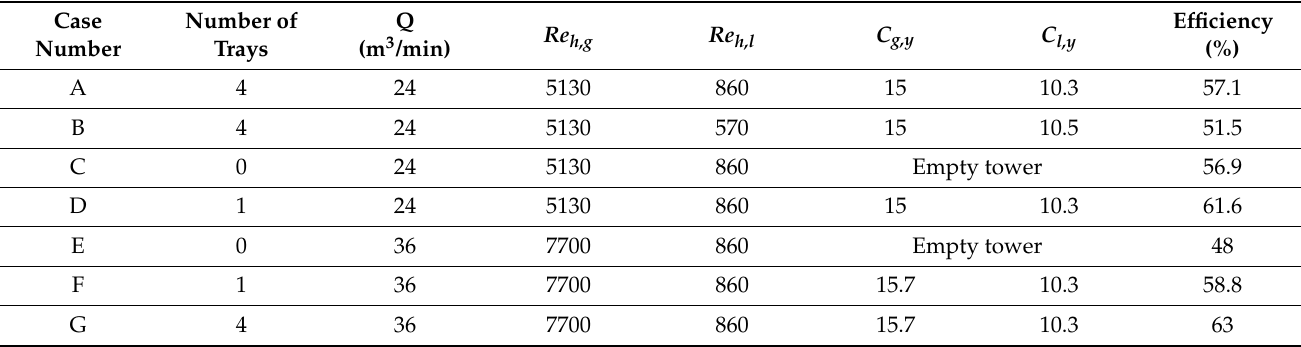
Table 6. This table highlights the different cases of small-scale tower that computed by porous media model with SO 2 removal efficiencies at